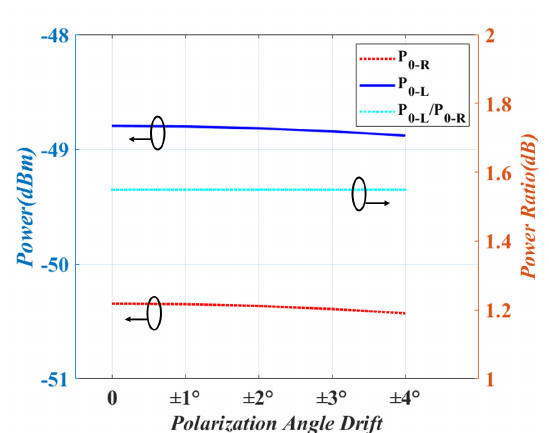
Figure 14. Powers of the beat signal pairs and their power ratios using different values for polarization angle drift in a single-tone signal, where f 0 = 8.3